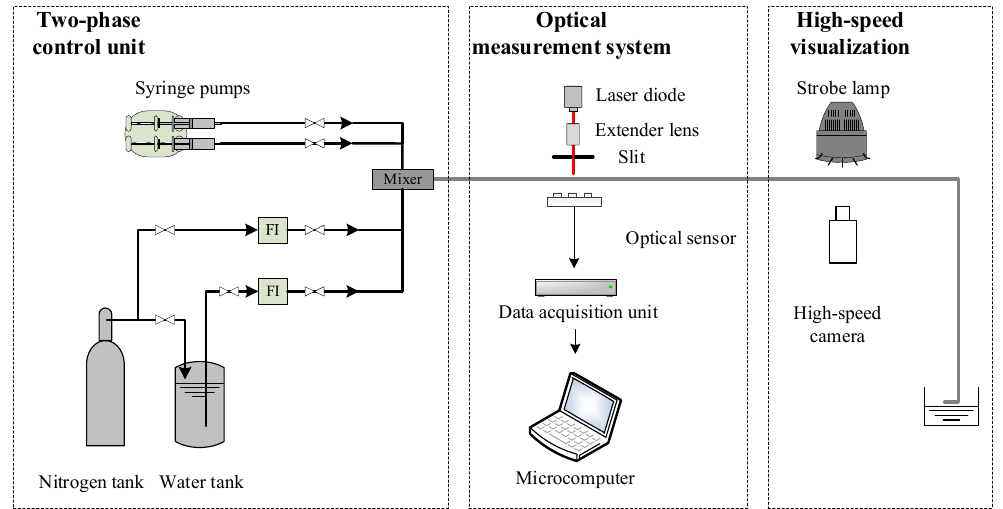
Figure 1. Experimental apparatus of the gas-liquid two-phase flow.